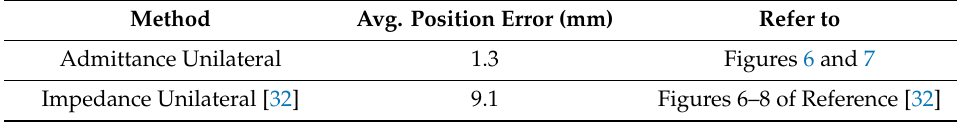
Table 5. Comparison of the position errors.